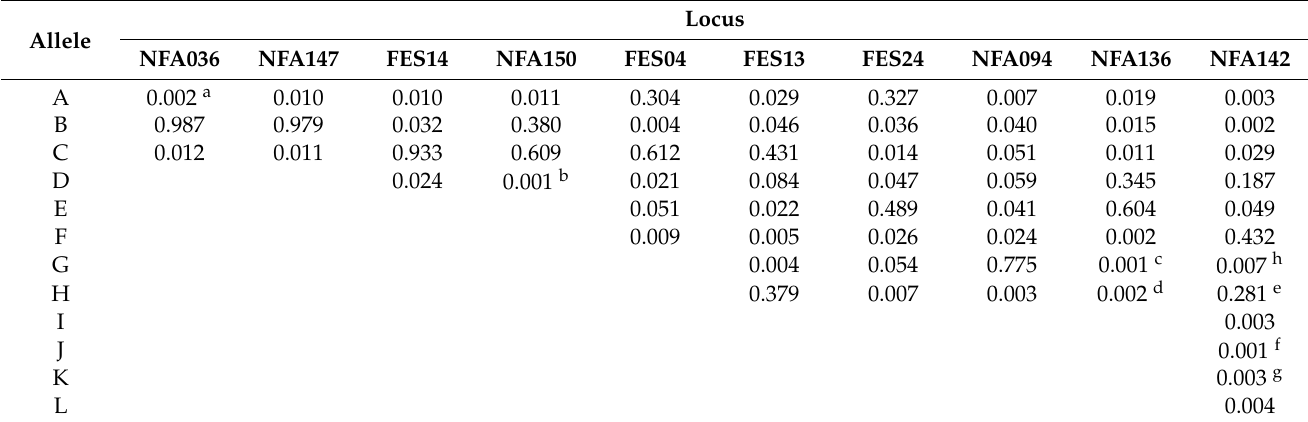
Table 3. Alleles frequency distribution of the 10 polymorphic EST-SSR loci revealed in this